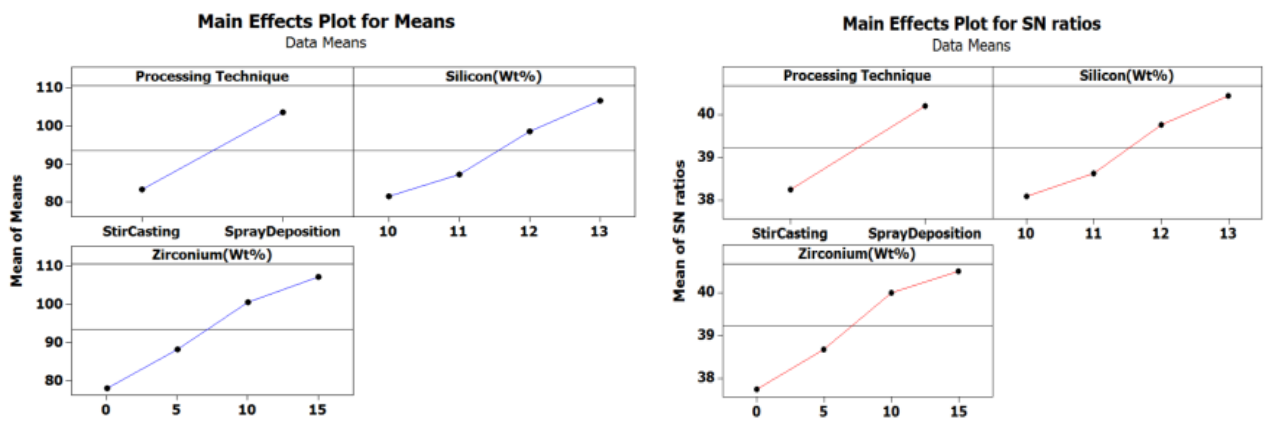
Figure 22. Main effects plot for means and SN ratio.